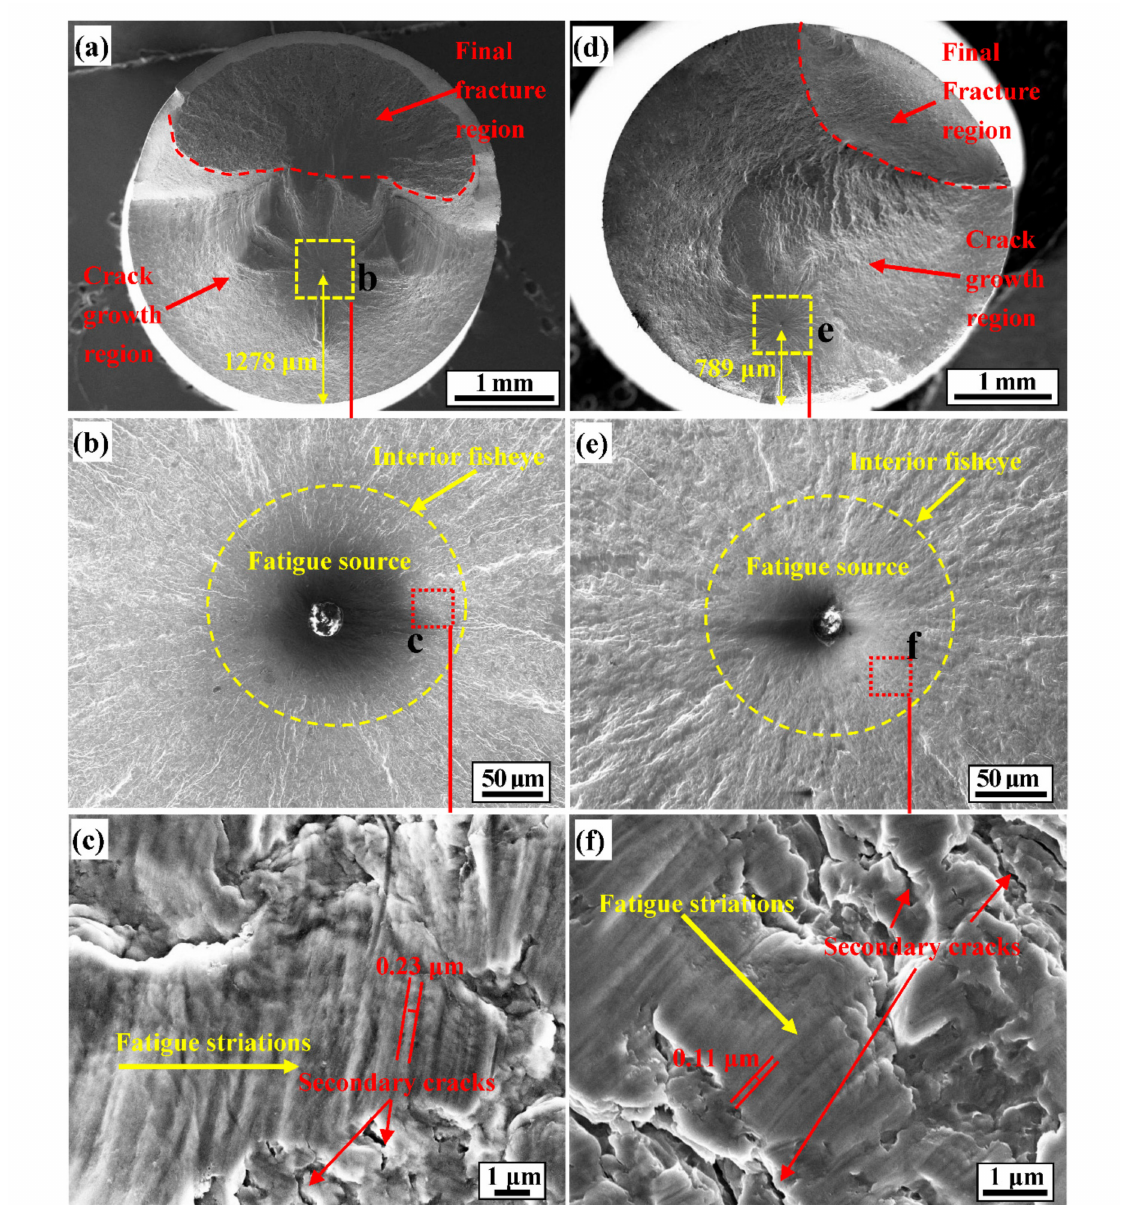
Figure 8. Fractographs of 51CrV4 spring steel with A = 0.752 (loading of 870 MPa and N f = 1.32 × 10 6 cycles) and A = 0.469 (loading of 870 MPa and N f = 4.86 × 10 6 cycles). ( a ) Macroscopic fracture for A = 0.752; ( b ) crack initiation area for A = 0.752; ( c ) fatigue striation features in fisheye area for A = 0.752; ( d ) macroscopic fracture for A = 0.469; ( e ) crack initiation area for A = 0.469; ( f ) fatigue striations features in fisheye area for A =